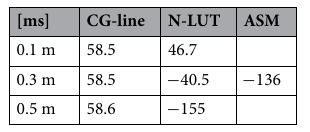
Table 1. Average margin times for all datasets.